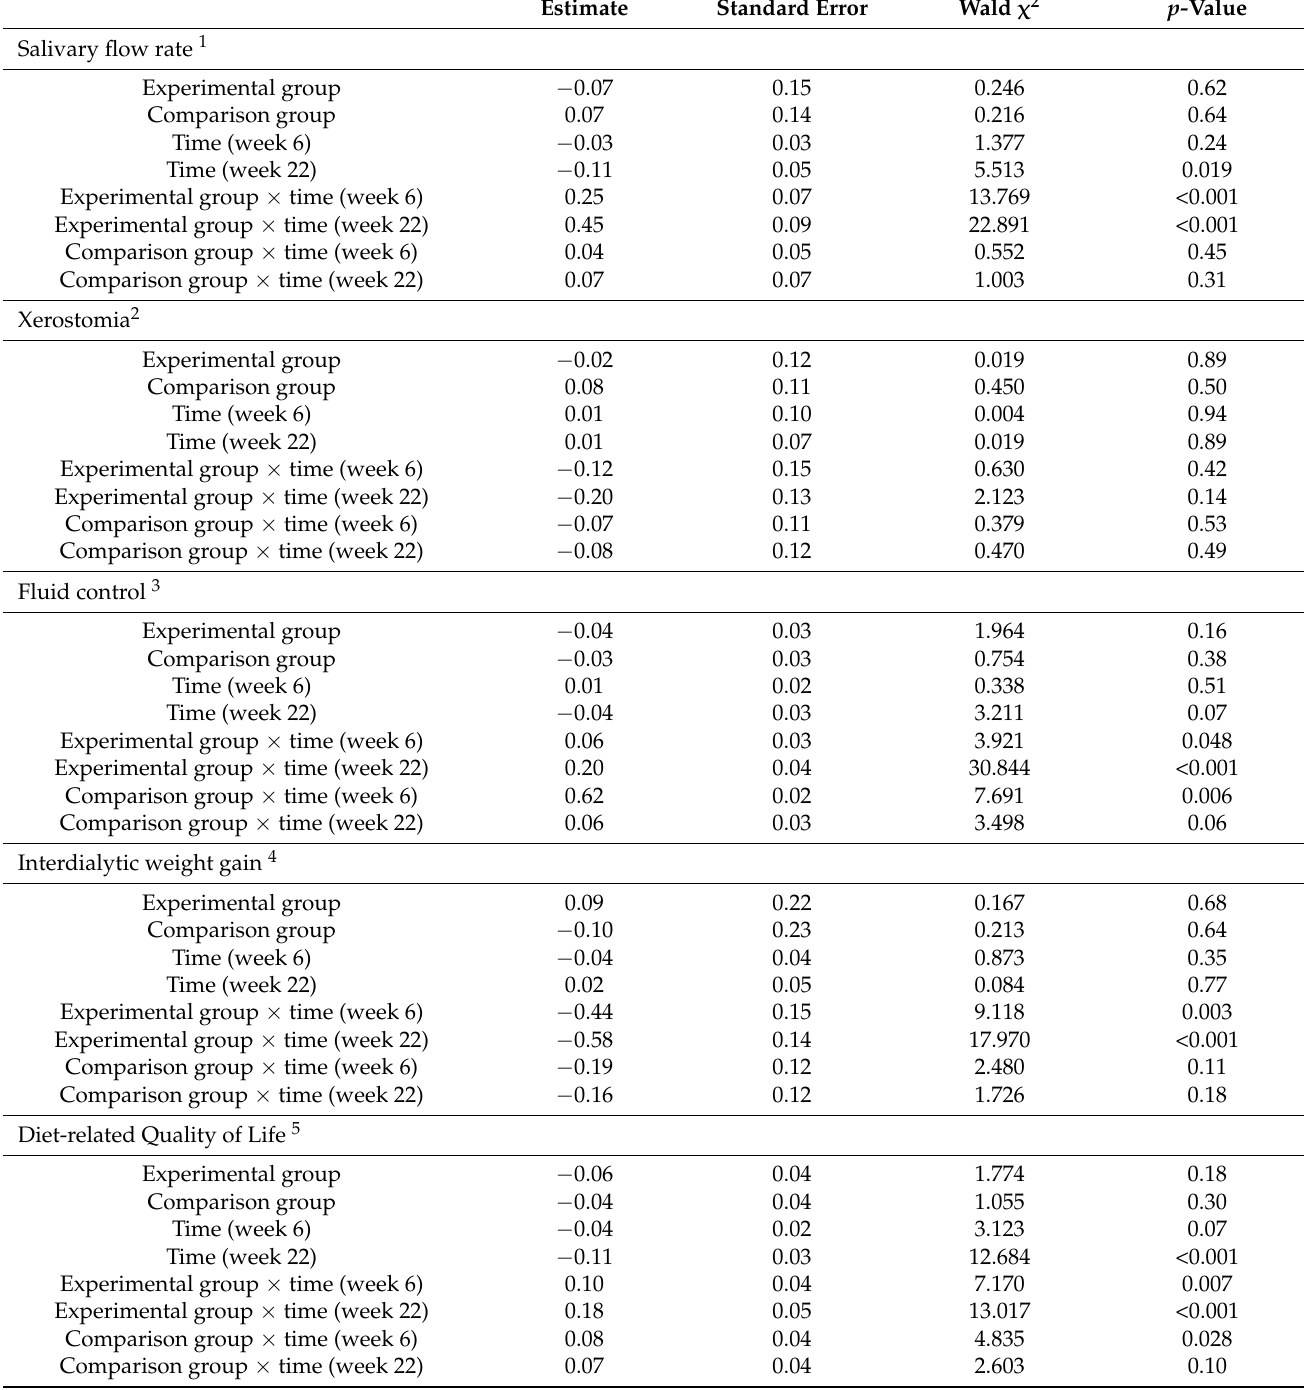
Table 3. Generalized estimating equation analysis of salivary flow rate, xerostomia, fluid-restriction adherence, interdialytic weight gain and diet-related quality of